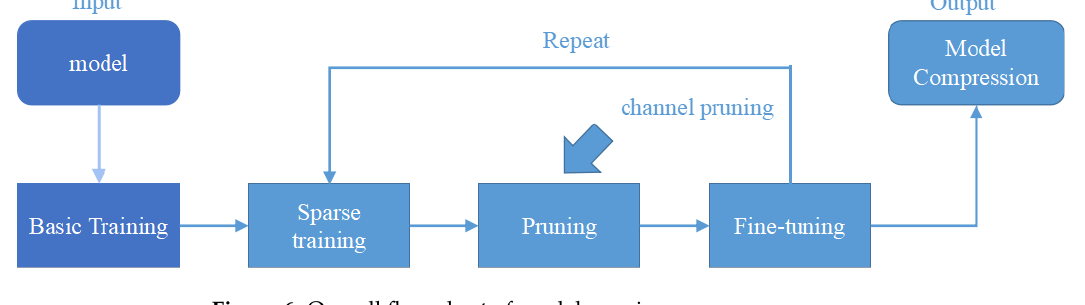
Figure 6. Overall flow chart of model pruning.